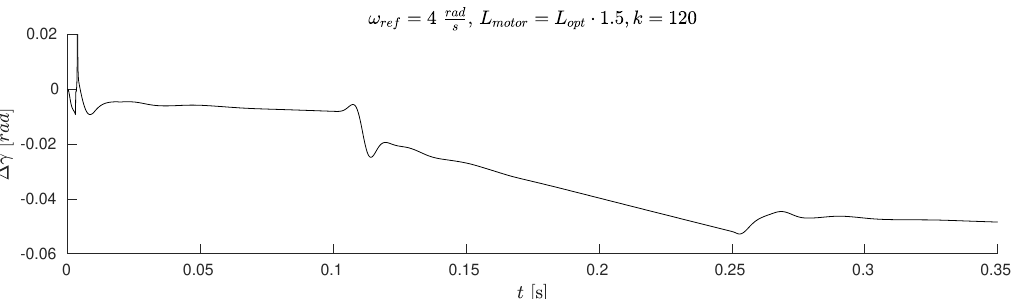
Figure 15. Reference i q of the inductance of the motor, reduced the value of gain k ; the initial position equals 0 ◦ .